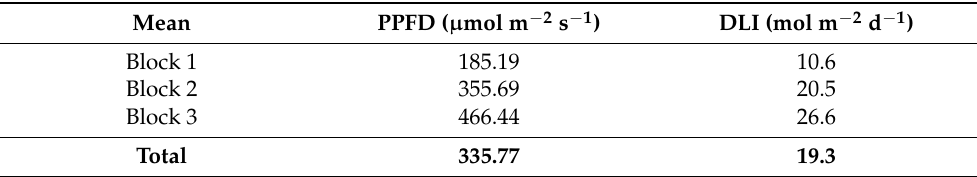
Table 1. Three blocks with three different PPFD and